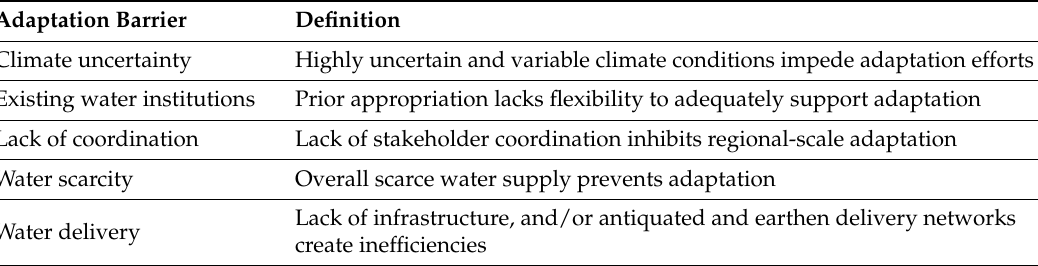
Table 5. Definition of adaptation barriers